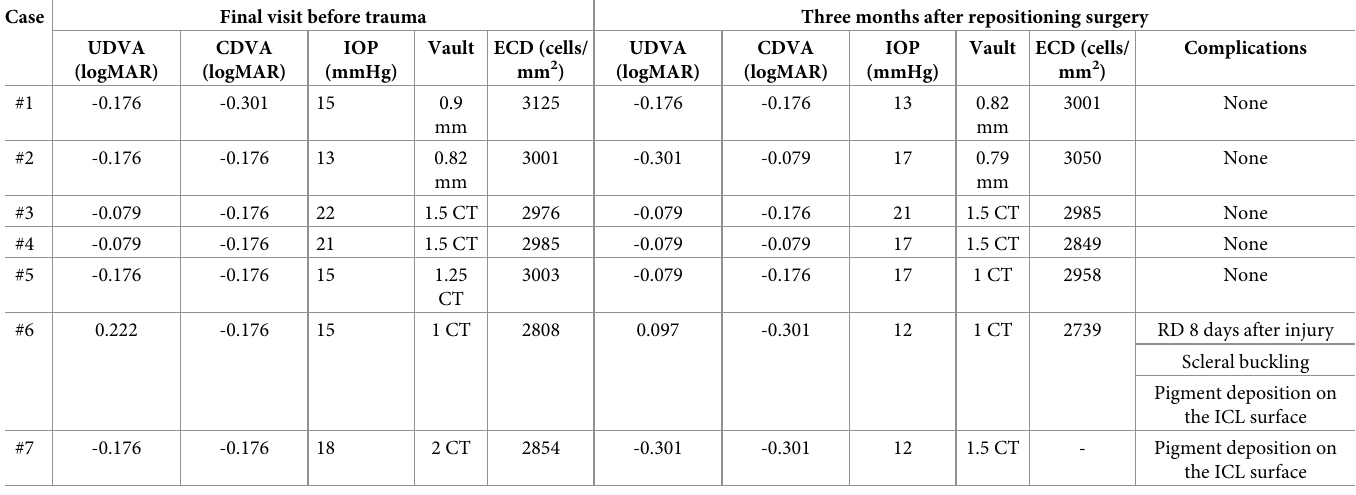
Table 2. Clinical outcomes after ICL repositioning surgery.